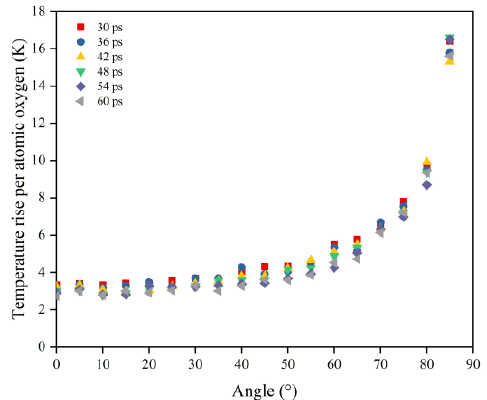
Figure 19. Temperature rise of the Kapton caused by per atomic oxygen at different incident angles at different time nodes.